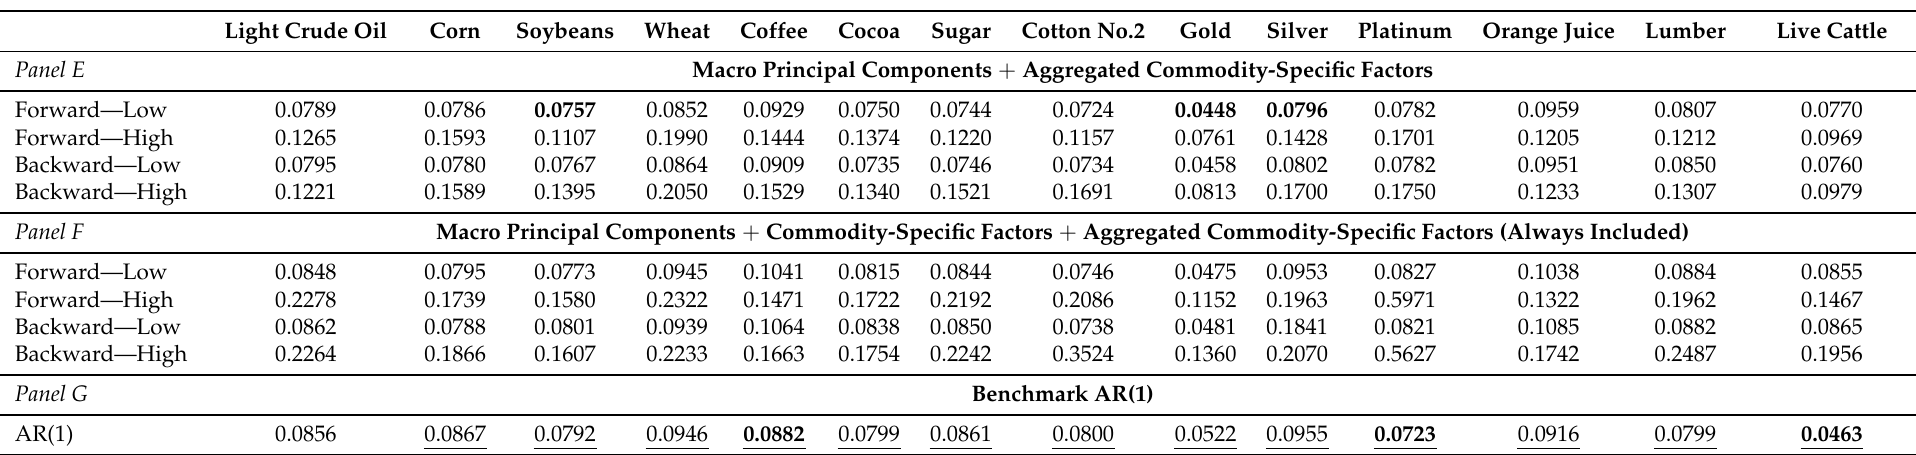
Table 2. Root mean square error forecast performances—weighting on the basis of predicted risk-aversion regime probabilities. The table reports the RMSFE